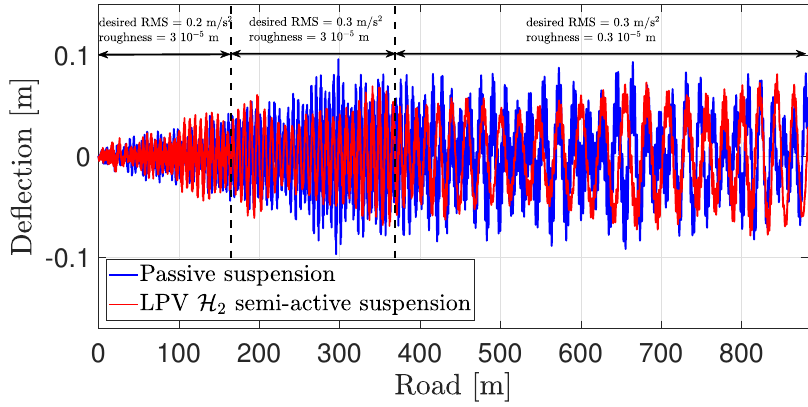
Figure 29. Resulting deflection at the front right corner.